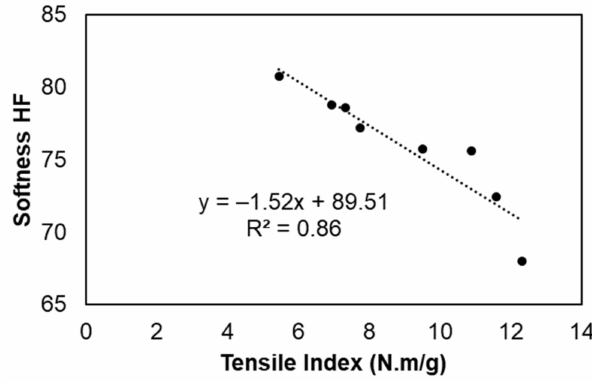
Figure 9. Correlation between the tensile index and softness HF of tissue